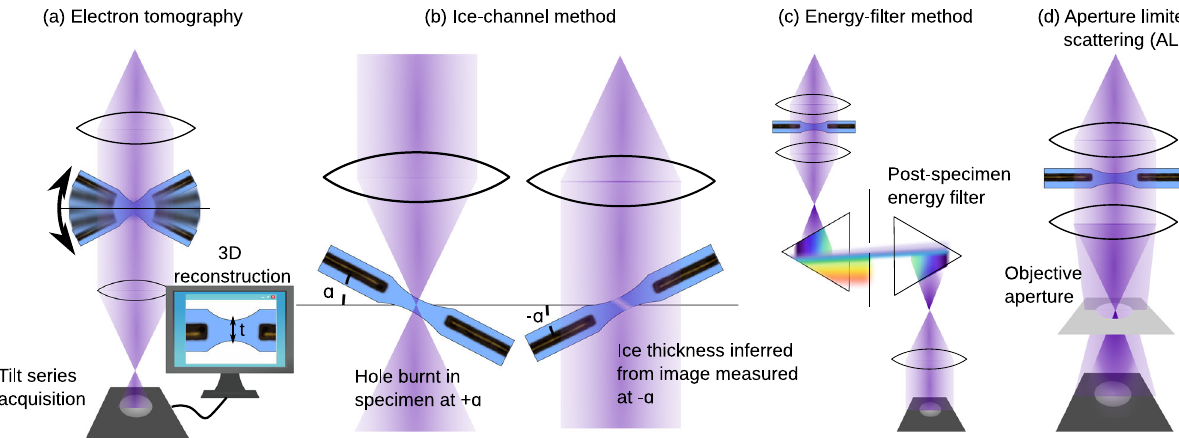
Fig. 1 Methods for measuring ice thickness in cryo-TEM. a 3D reconstruction from tilt series tomography, b the ice-channel method, where the thickness is inferred by fi rst burning a hole at one sample tilt orientation and then measuring the projected size of the ice channel at another orientation or by measuring the fraction of electron beam blocked by c a post-specimen energy fi lter or d objective aperture in the back-focal